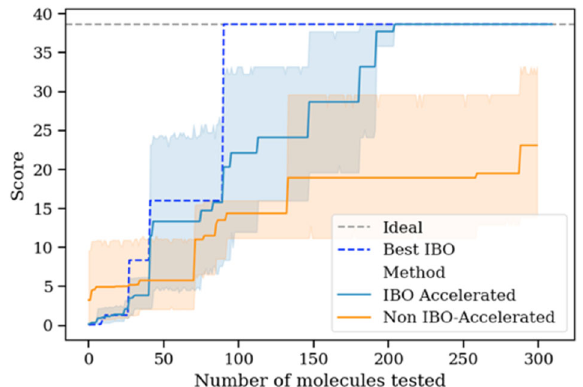
Fig. 8 A comparison between work fl ows accelerated by Bayesian optimization (IBO accelerated) and those without this accelera- tion. Solid lines represent bootstrap estimates of the mean run from 5 replicate work fl ows, with shaded areas representing 95% con fi dence intervals for that estimate. Ideal behavior (i.e. the best possible score) is shown as a gray dashed line, and the best IBO- accelerated work fl ow is shown as a blue dashed